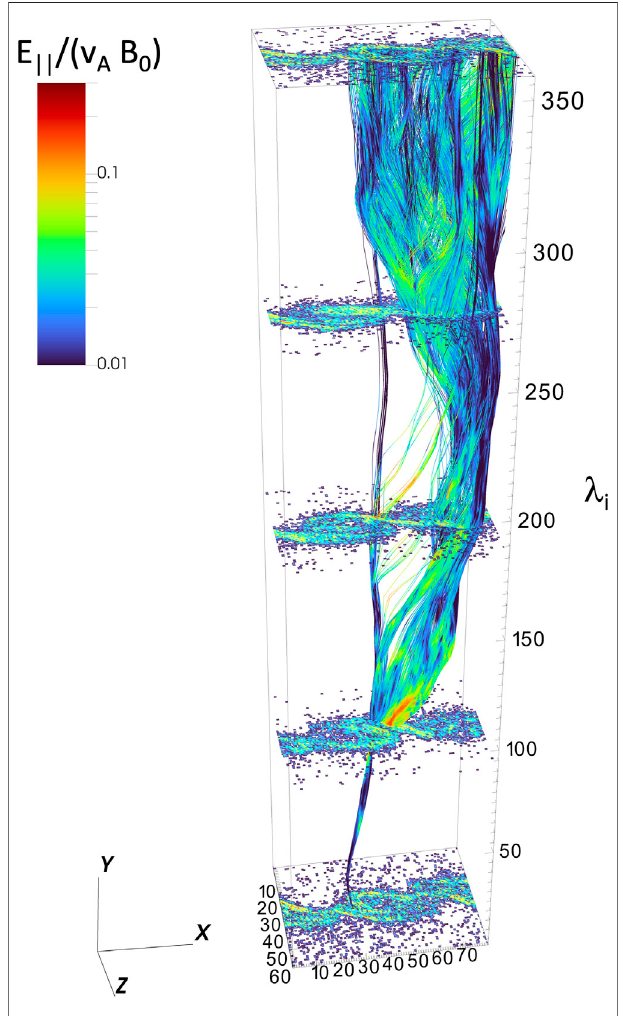
FIGURE 6 | Magnetic fi eld line traces through KH active regions in a 3-D hybrid simulation. The magnitude of the parallel electric fi eld ( E (cid:3) /( v A B 0 ) is indicated in color. Spatial units are in ion inertial length ( λ i